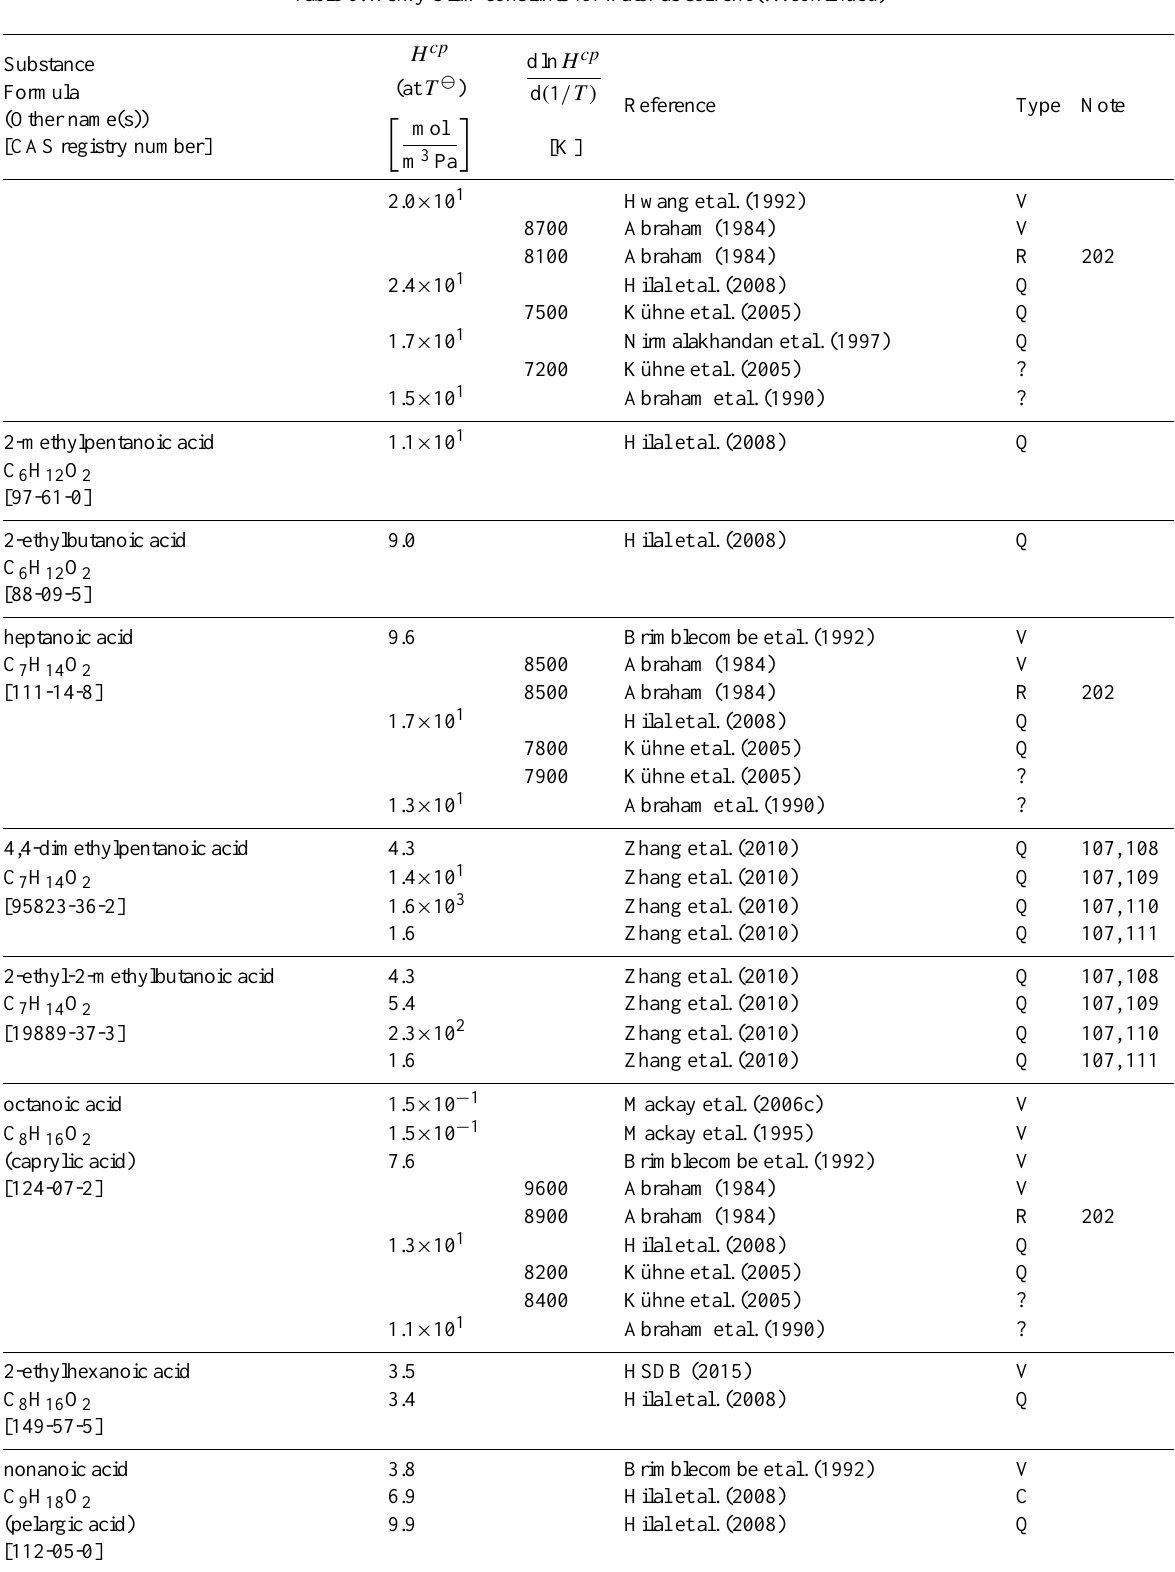
Table 6: Henry’s law constants for water as solvent